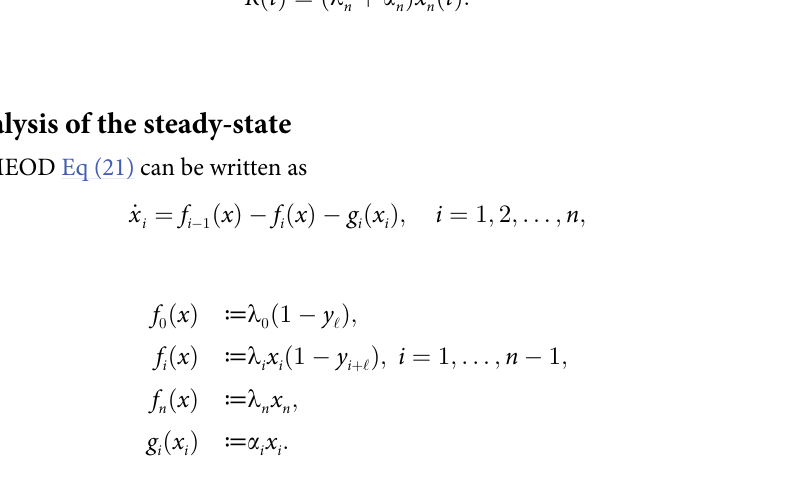
Fig 11. The steady-state output rate R as a function of E for a EFEIOD with n = 3, ℓ = 1, λ 0 = 1, λ all i and r = 1/ q .